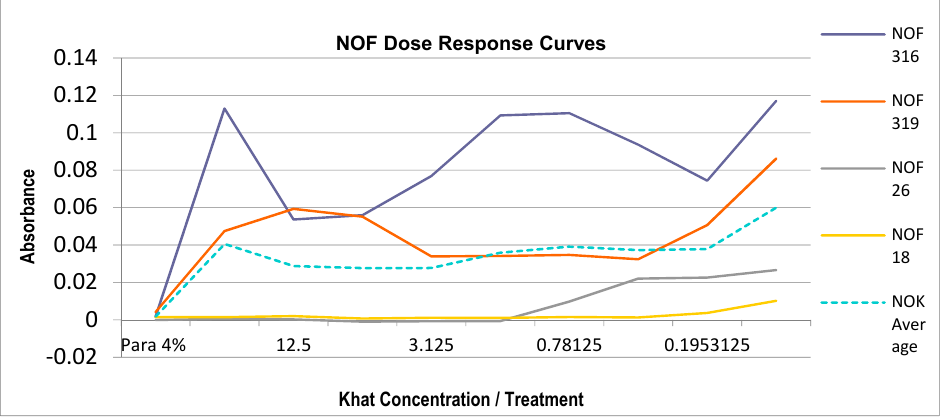
Figure 5. Comparison of absorbance values from MTT Assay for NOF 18, NOF 26, NOF 319, and NOF 316 cells treated with different concentrations of the Khat solution (25 mg/mL to 0.195 mg/mL). Medium only with cells specific for each experiment was used as a negative control, while 4% paraformaldehyde was used as a positive control showing complete cell death. Aqua dotted curve = average of the 4 assays.